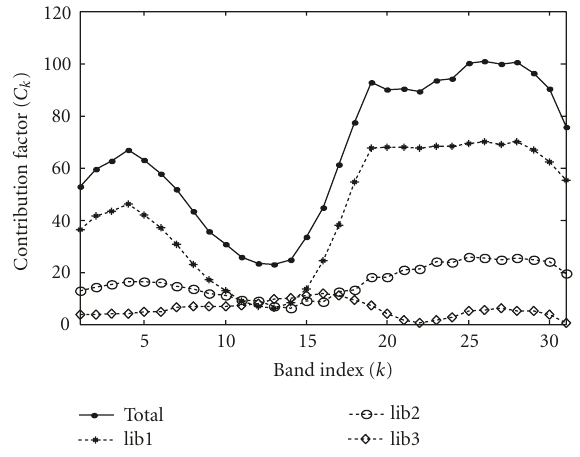
Figure 13: Illustration of contribution coe ffi cient of each